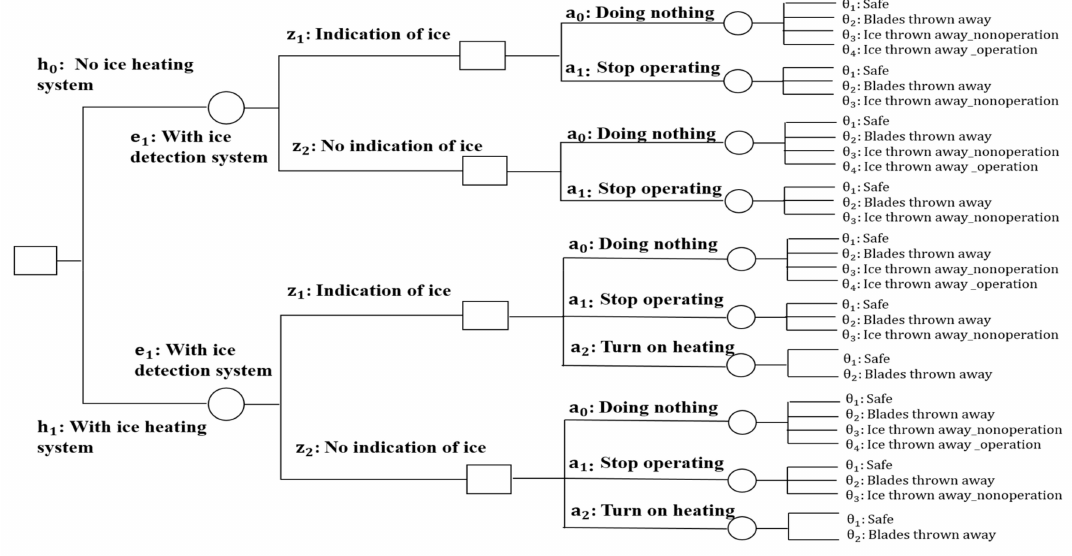
Figure 7. Illustration of the full decision tree for risk assessment of the value of action in the framework of wind turbines close to